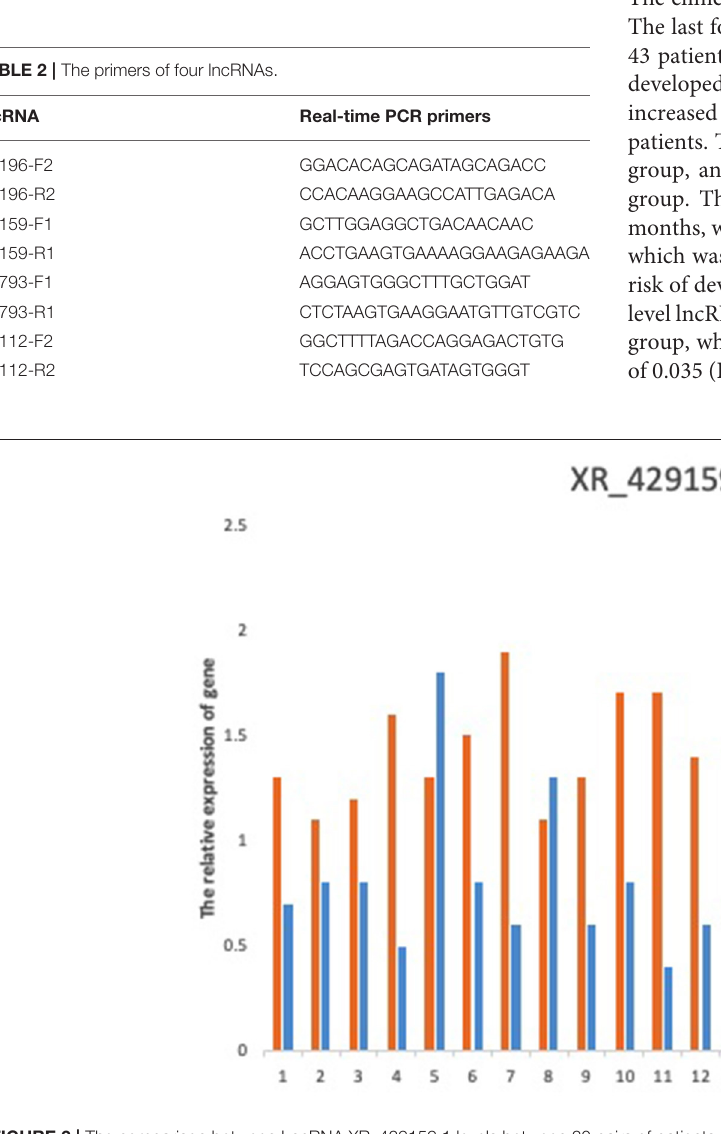
Frontiers in Oncology |